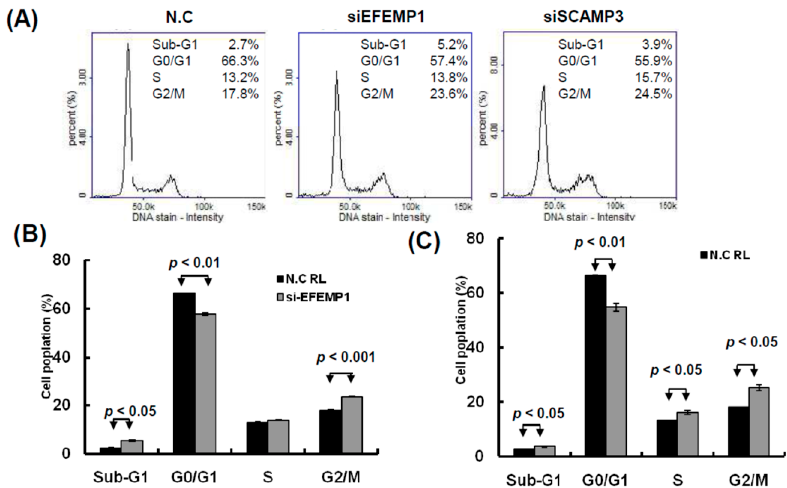
Figure 9. Knockdown of EFEMP1 and SCAMP3 impaired the cell cycle progression of melanoma cells. ( A ) After siEFEMP1, siSCAPM3, or scramble control transfection for three days, the cell cycle distributions of A2058 were examined by image-flow cytometry analysis. ( B ) EFEMP1 and SCAMP3 knockdown increased the number of cells in the G2/M and S phase and reduce the number of cells in the G0/G1 phase compared with the control cells. ( C ) After A2058 cells were transfected with siEFEMP1, siSCAPM3, or scramble control for three days, cells were stained with propidium iodide, then cell apoptosis was assessed by image-flow cytometric analysis. ( D ) Percentage of apoptotic cells was quantified and was presented. Data are presented as the mean ± standard deviation of three independent experiments.